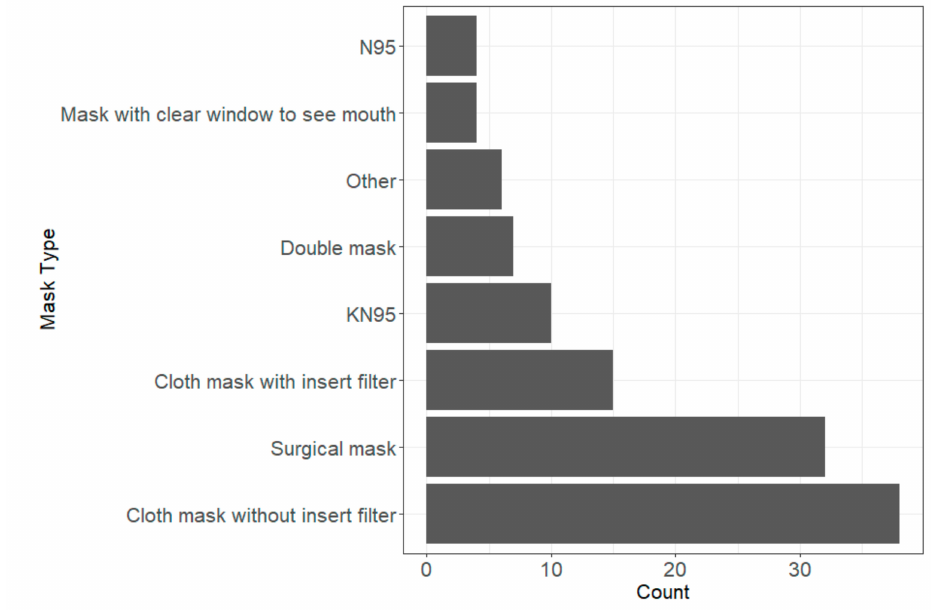
Figure 1. Count of mask types used by teacher participants during the 2020–2021 school year. Total count can be greater than the total number of participants, as participants could select more than one mask